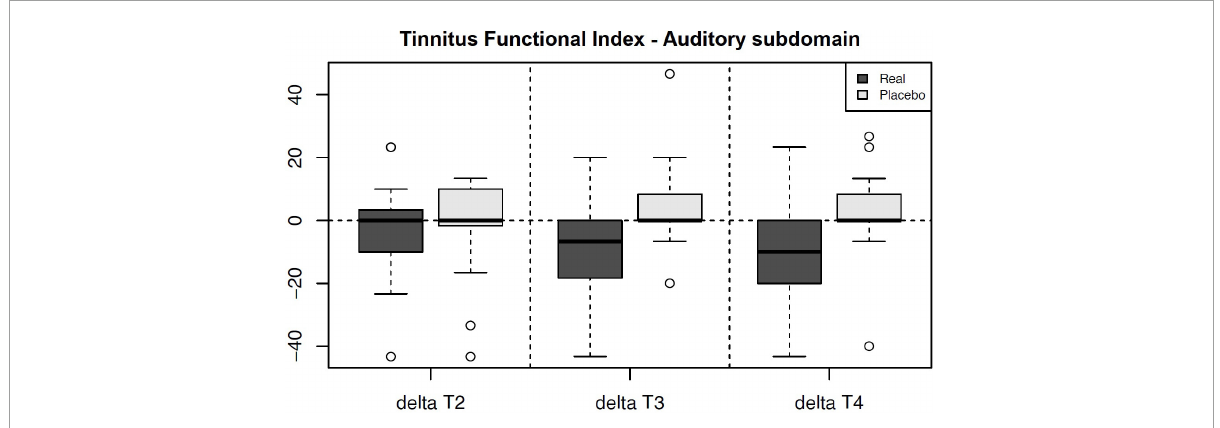
FIGURE3 Chart depicting the outcome changes in the Auditory subdomain of Tinnitus Functional Index compared to the T1 baseline and their side-by-side comparison between the arms. The results in T3 and T4 are statistically significant a denote a decrease (improvement) in the Auditory subdomain of the active group. Note – Real = Active Group, Placebo = Sham Group.